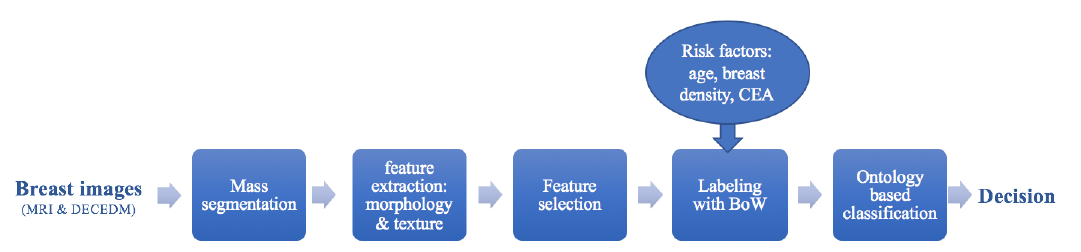
Figure 1. An overview of the proposed computer aided diagnosis (CAD)